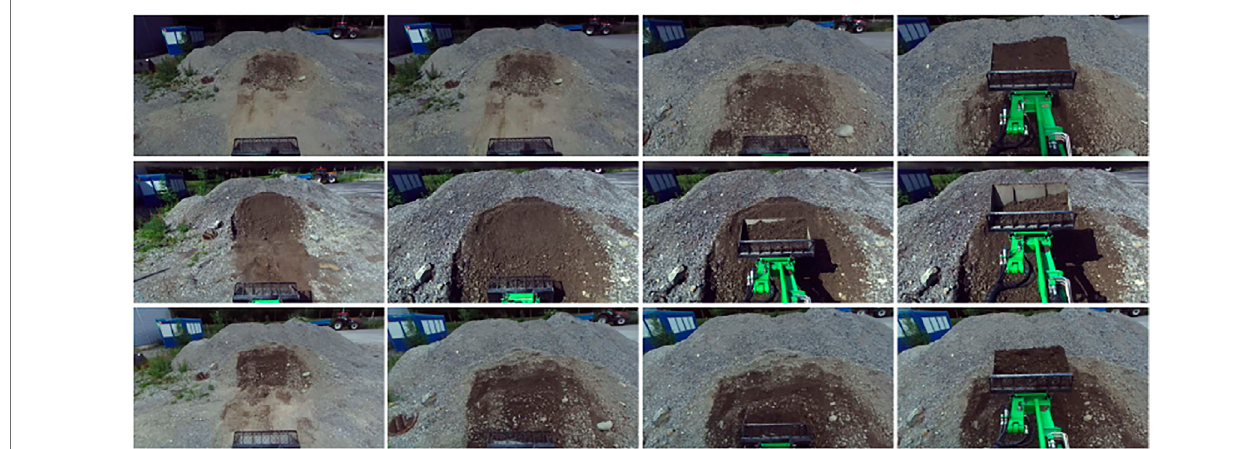
FIGURE 5 | Examples of images from D summer .